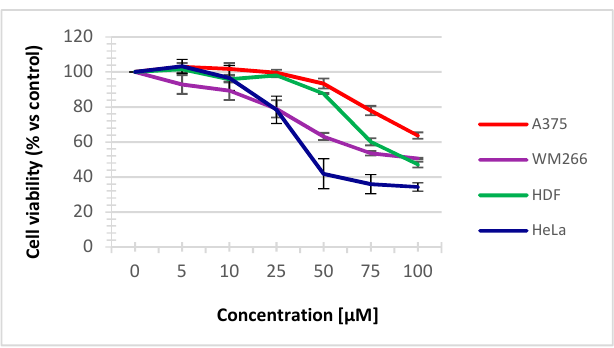
Figure 4. Cell viability assay of complex 6 on HeLa, A375, WM266, and human dermal fibroblasts (HDF) cell lines. The cells were incubated in the presence of compound at the indicated concentrations at 37 °C for 72h. Cell viability was measured by using the MTT assay. The results are presented as the percentage of viable cells with respect to the control (vehicle treated cells) and are expressed as means ± SE of at least three independent experiments. A p ≤ 0.01 was observed from 50 to 100 μM for WM266 and HDF, at 75 and 100 μM for A375 and HeLa; a p < 0.05 was observed at 25 and 50 μM for HeLa.